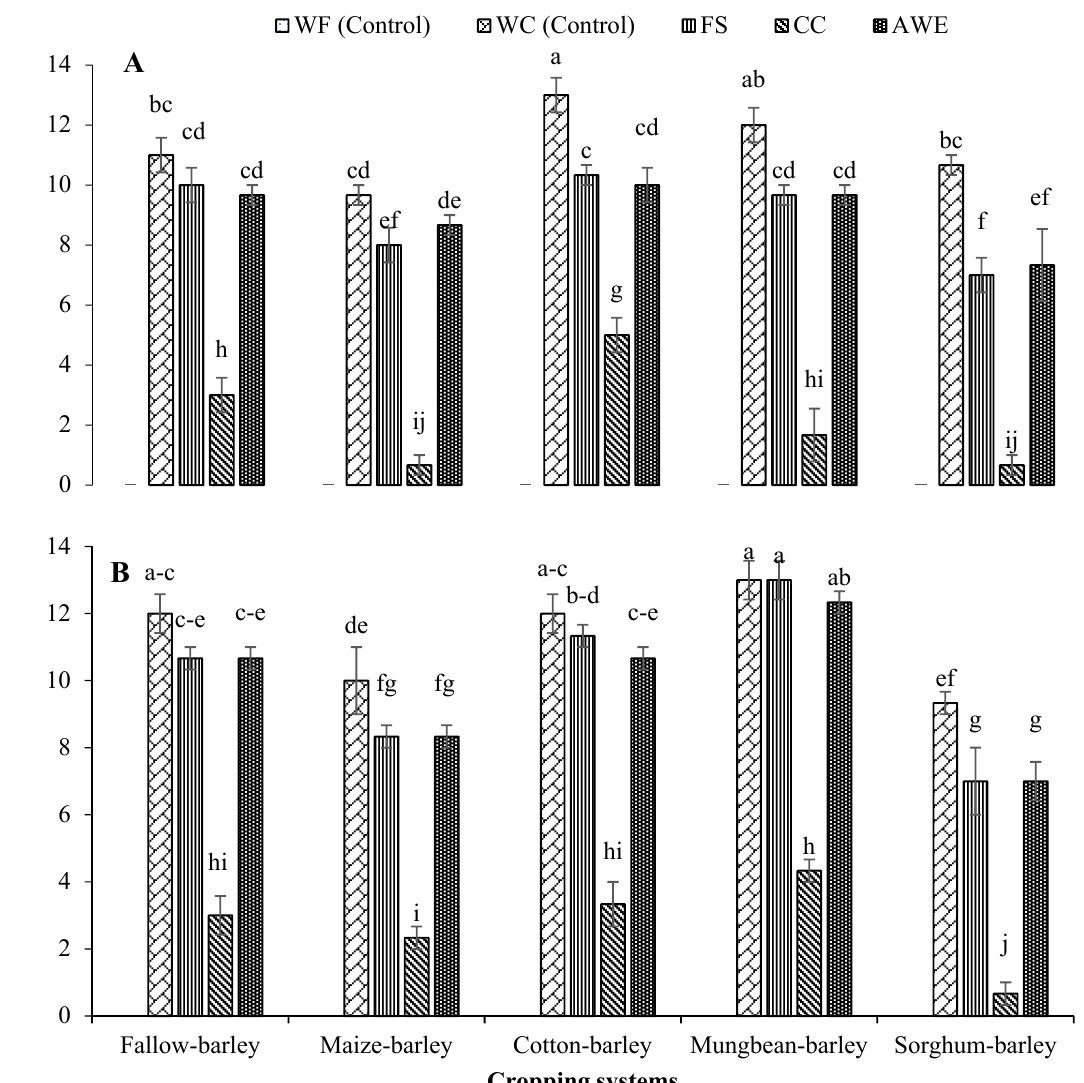
Figure 1. Influence of different barley-based cropping systems on weed diversity (number of weeds species) under various weed management methods during 2017–2018 ( A ) and 2018–2019 ( B ) ± S.E. In the legend, WF = weed free (control), WC = weedy check (control), FS = false seedbed, CC = chemical control, AWE = allelopathic water extracts. The means sharing the same letters do not differ signifi- cantly at p ≤ 0.05 (LSD value at p ≤ 0.05 for 2017–2018 = 1.41, 2018–2019 =